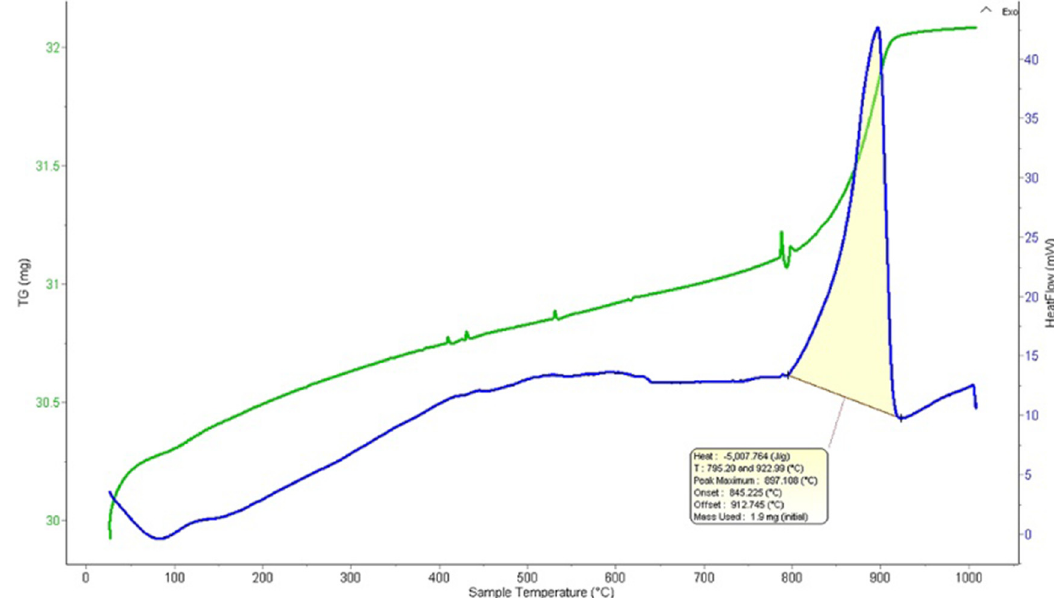
Fig. 4. DSC curves for heating rate 10 ° Cmin (cid:1) 1 of EB-PVD multi-layered TiAl 3 nanostructured coatings at heating rate 10 ° Cmin (cid:1) 1